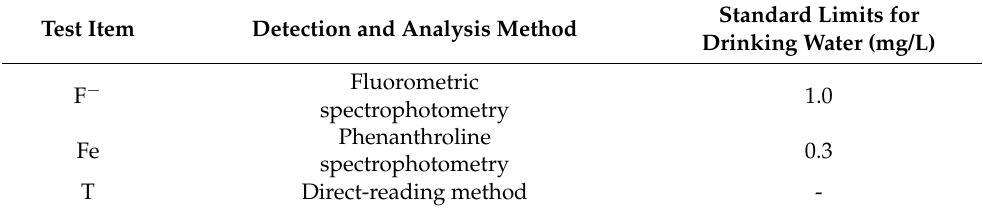
Table 4. Experiment detection method.